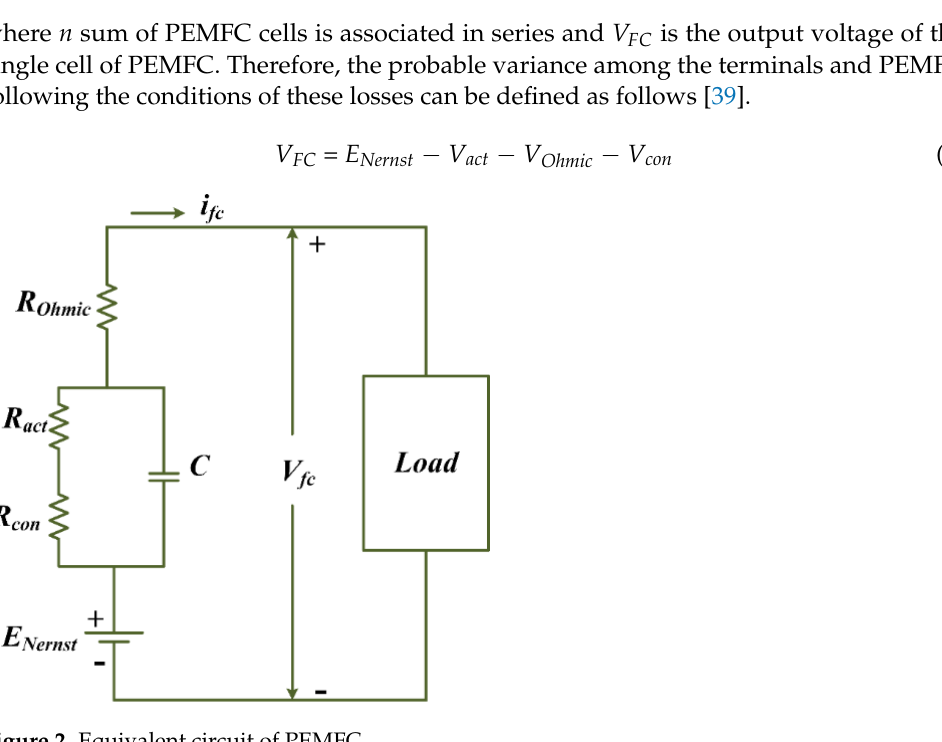
Figure 2. Equivalent circuit of PEMFC.